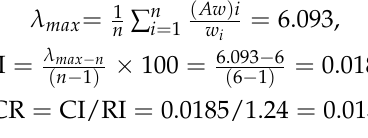
Table 4. Ranking of landscape preferences.